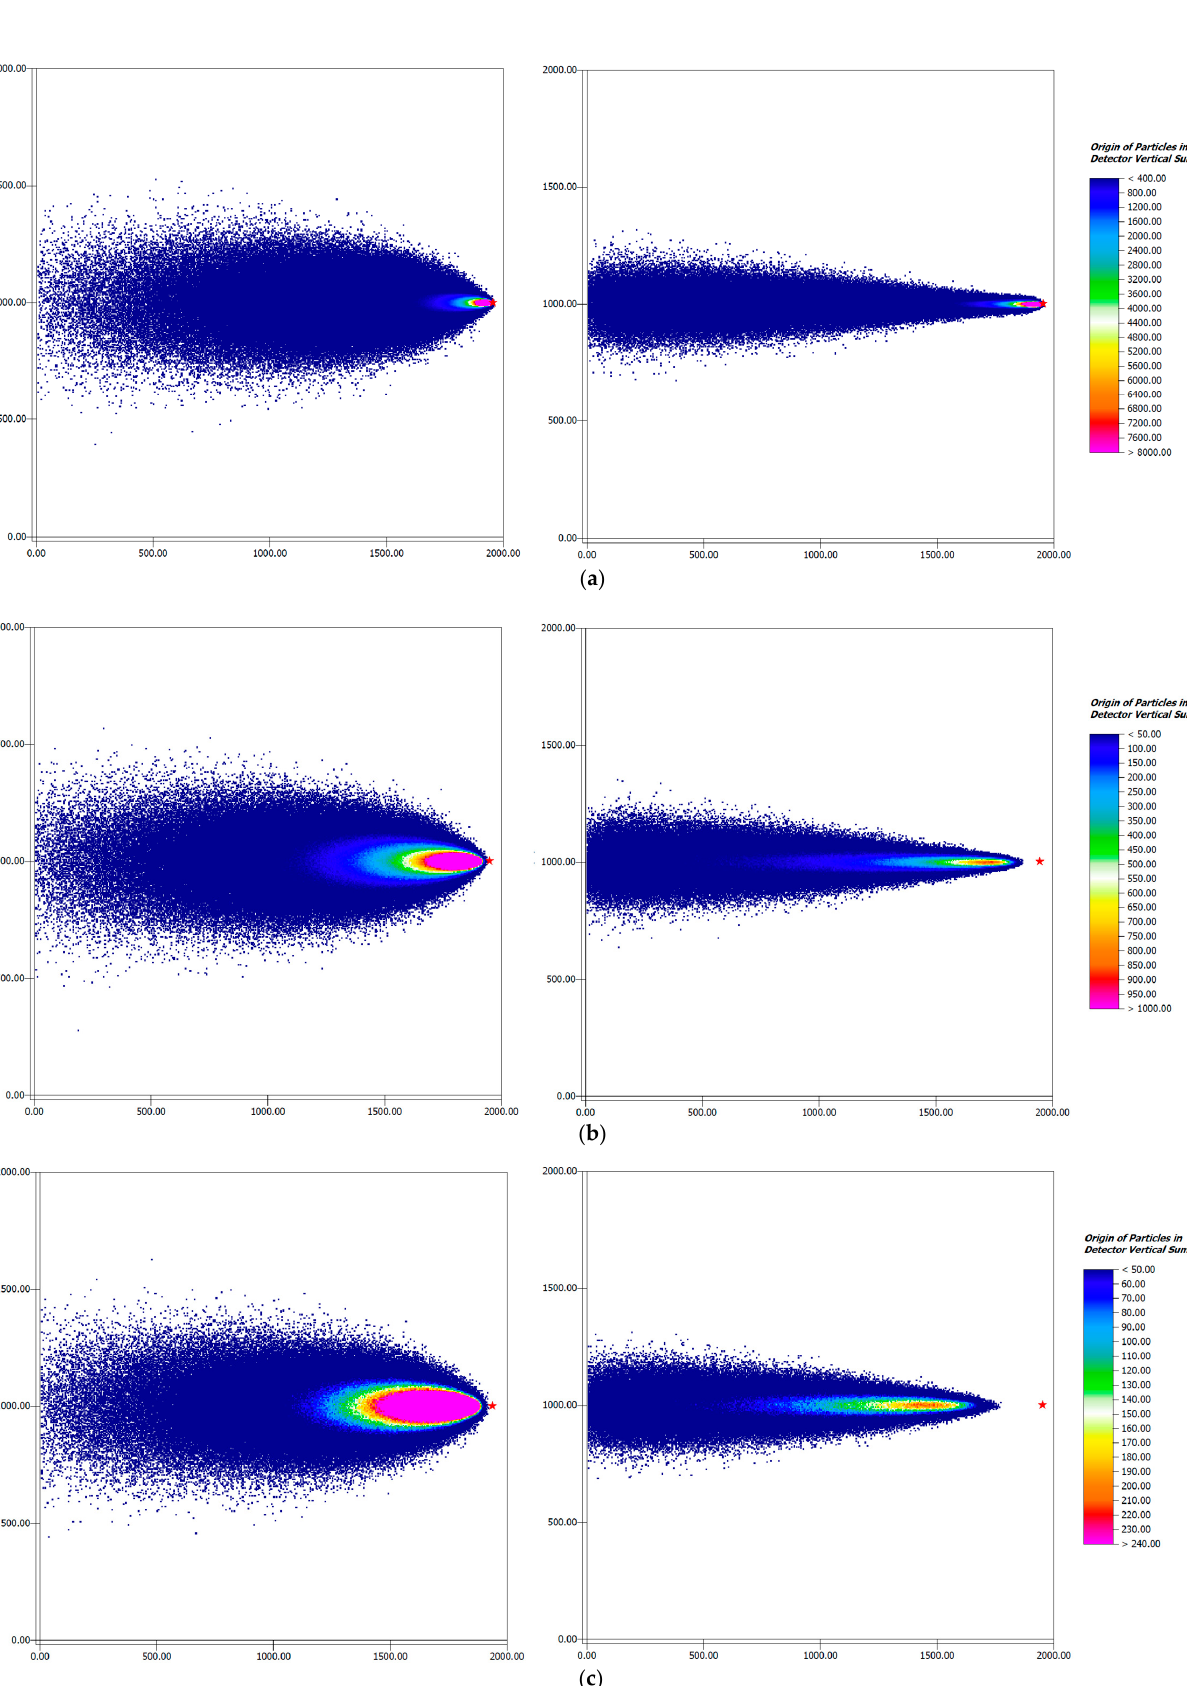
11 of 17 Table 3. Crosswind distance between f max and detector ( 𝑥 (cid:3040)(cid:3028)(cid:3051) ). Detector 3 m